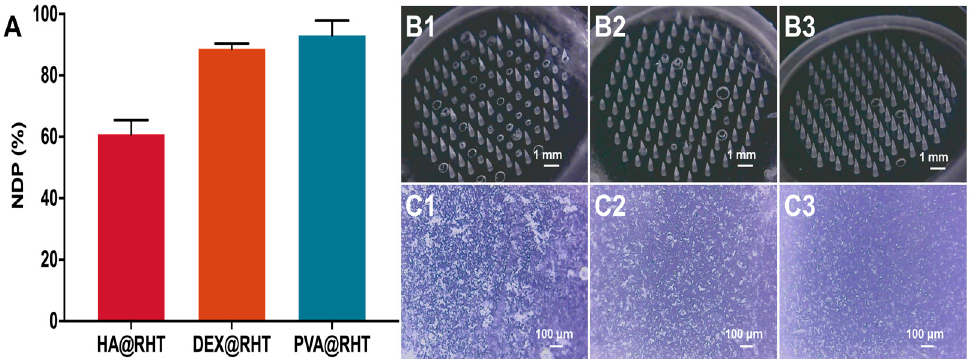
Figure 6. The influence of drug-loaded carriers on the ( A ) DNP ( n = 3) and ( B ) morphology of particle-embedded gas-propelled MNs: ( B1 ) HA@RHT, ( B2 ) DEX@RHT, and ( B3 ) PVP@RHT. ( C ) The influence of carriers on the morphology of drug particles: ( C1 ) HA@ RHT, ( C2 ) DEX@RHT,